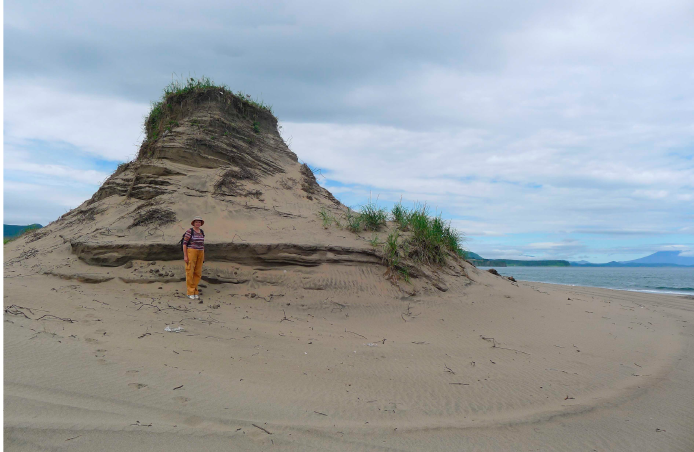
Figure 9. Dune of the LIA on the Pacific side of Kunashir Island, Southern Kuril Islands. Climate 2023 , 11 , x FOR PEER REVIEW